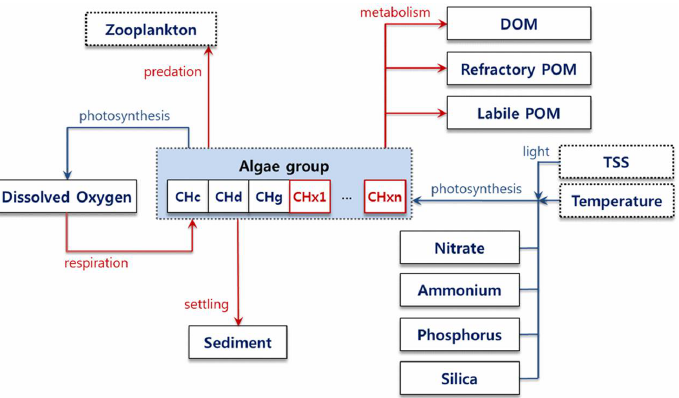
Figure 2. Schematic of the reactions among multiple algal species in EFDC-NIER (CHc: Cyanobacteria, CHd: Diatoms, CHg: Green algae, CH1~CHx: Multiple algal species) [39]. To perform water quality modeling using EFDC-NIER, water quality observation data for total nitrogen (TN) (mg/L), nitrate nitrogen (NO₃−N) (mg/L), ammonia nitrogen (NH₃−N) (mg/L), total phosphorus (TP) (mg/L), water temperature (°C), dissolved total nitrogen (DTN) (mg/L), dissolved total phosphorus (DTP) (mg/L), phosphate (PO₄−P) (mg/L), chlorophyll-a (mg/m 3 ), biochemical oxygen demand (BOD) (mg/L), chemical oxygen demand (COD) (mg/L), dissolved oxygen (DO) (mg/L), and total organic carbon